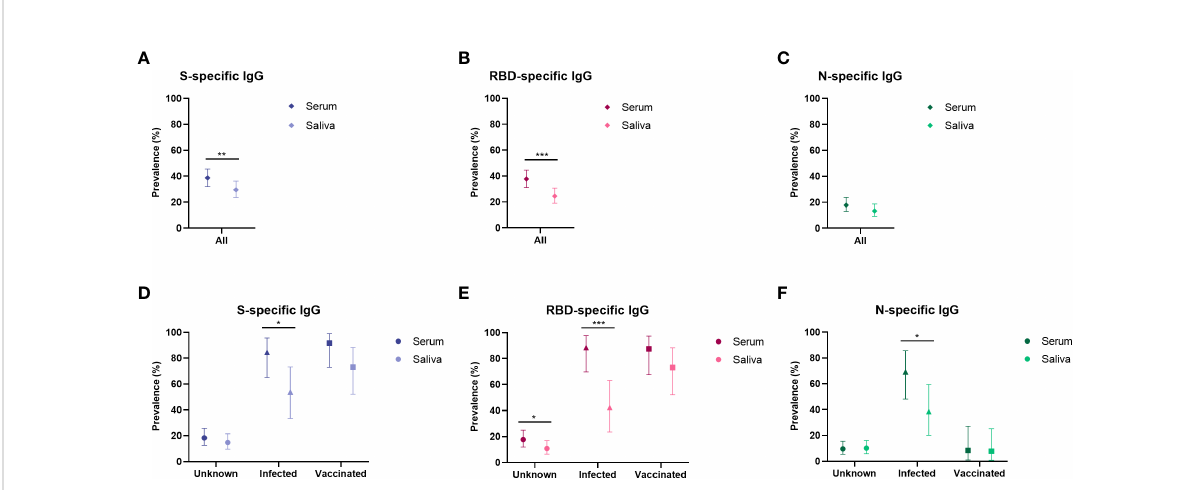
FIGURE 3 Prevalence of SARS-CoV-2 speci fi c antibodies in serum and saliva compared for population subgroups. Prevalence estimates of antibodies in serum and saliva compared in the total cohort (serum n = 212, saliva n = 216) speci fi c for (A) Spike, (B) RBD and (C) Nucleocapsid, and prevalence shown separately for the unknown group (serum n = 147, saliva n = 149), the infected group (serum n = 24, saliva n = 26) and the vaccinated group (serum n = 26, saliva n = 26) speci fi c for (D) Spike, (E) RBD and (F) Nucleocapsid. Prevalence estimates are the calculated proportion with a value above the determined cut-off. Estimates are shown with 95% con fi dence intervals. McNemar test was used for differences between paired proportions. S, spike; RBD, receptor binding domain of the spike; N, nucleocapsid; * = p < 0.050, ** = p ≤ 0.010, *** = p ≤